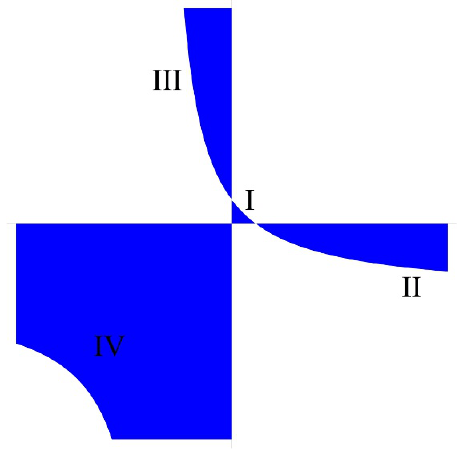
Figure 5 . Subregions for the integration of the massless double box diagram on the maximal cut. This plot is for the kinematic con(cid:12)guration, s = 1 and (cid:31) = 1 = 3. The two axes are the ISPs, z 8 and z 9 . These subregions are symmetric under the (cid:13)ip of two